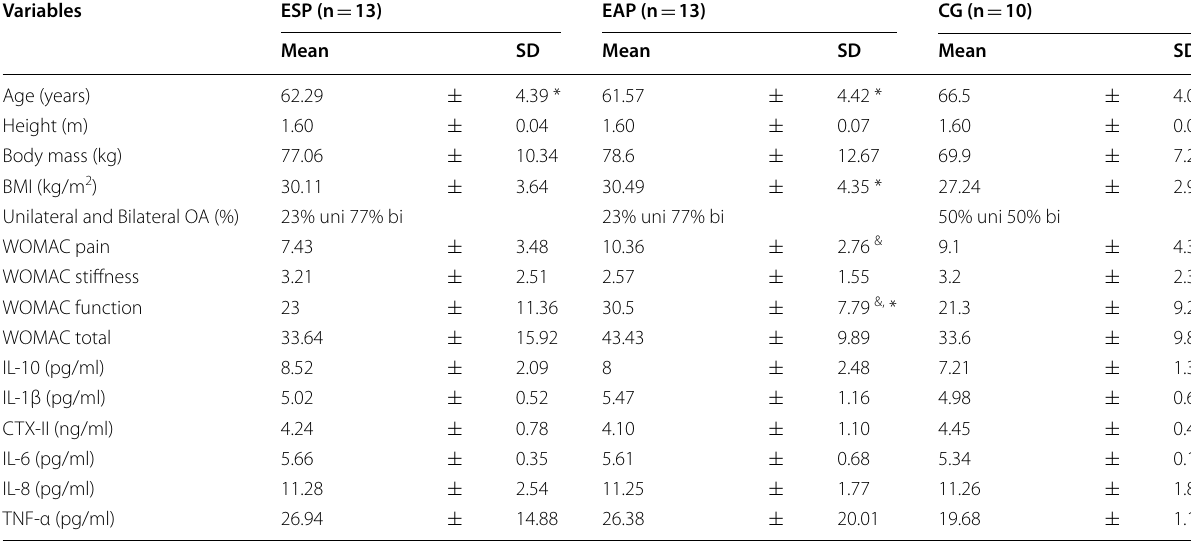
Table 1 Mean and SD of baseline values, anthropometric and demographic characteristics